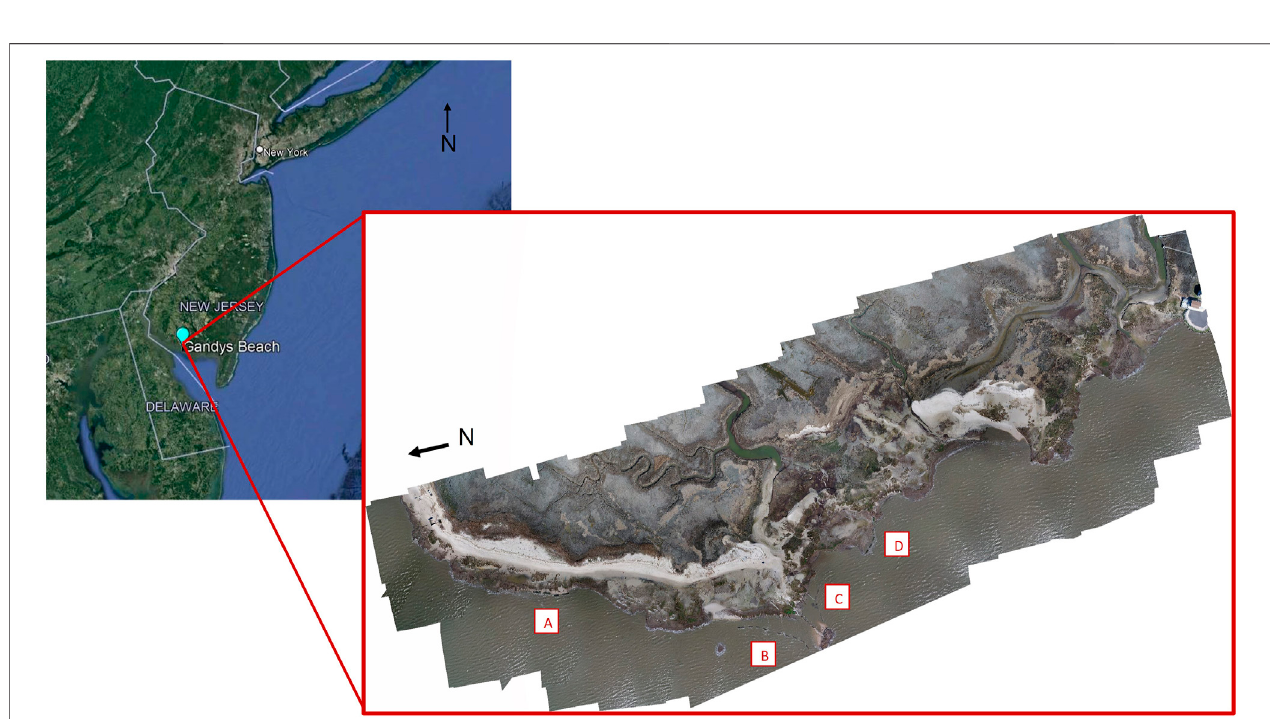
FIGURE 3 | Orthomosaic created from drone imagery of Gandys Beach Preserve with Sites A, B, C, and D labelled, April 2020.